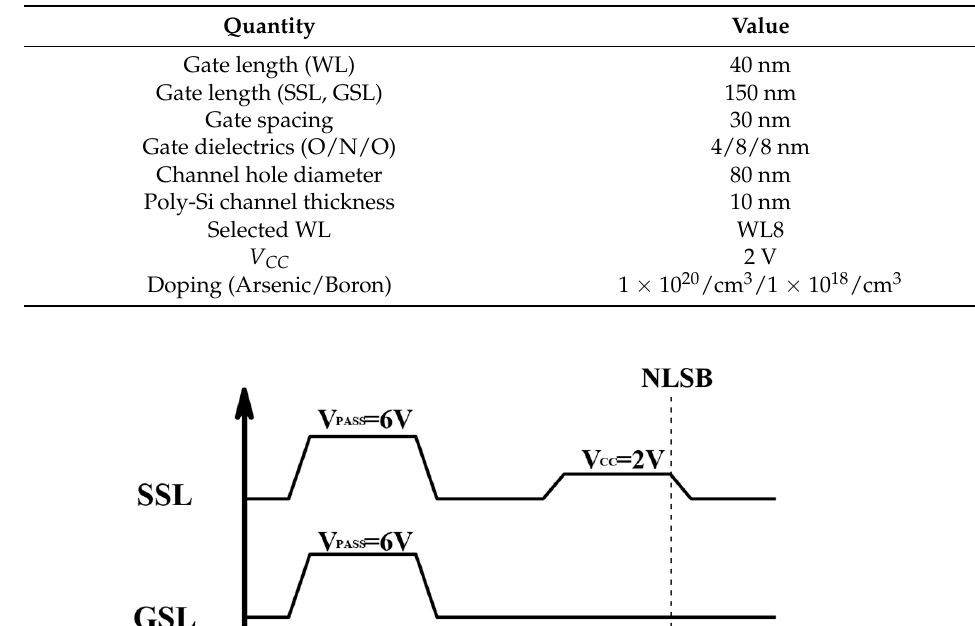
Table 1. Device parameters used in the simulation.